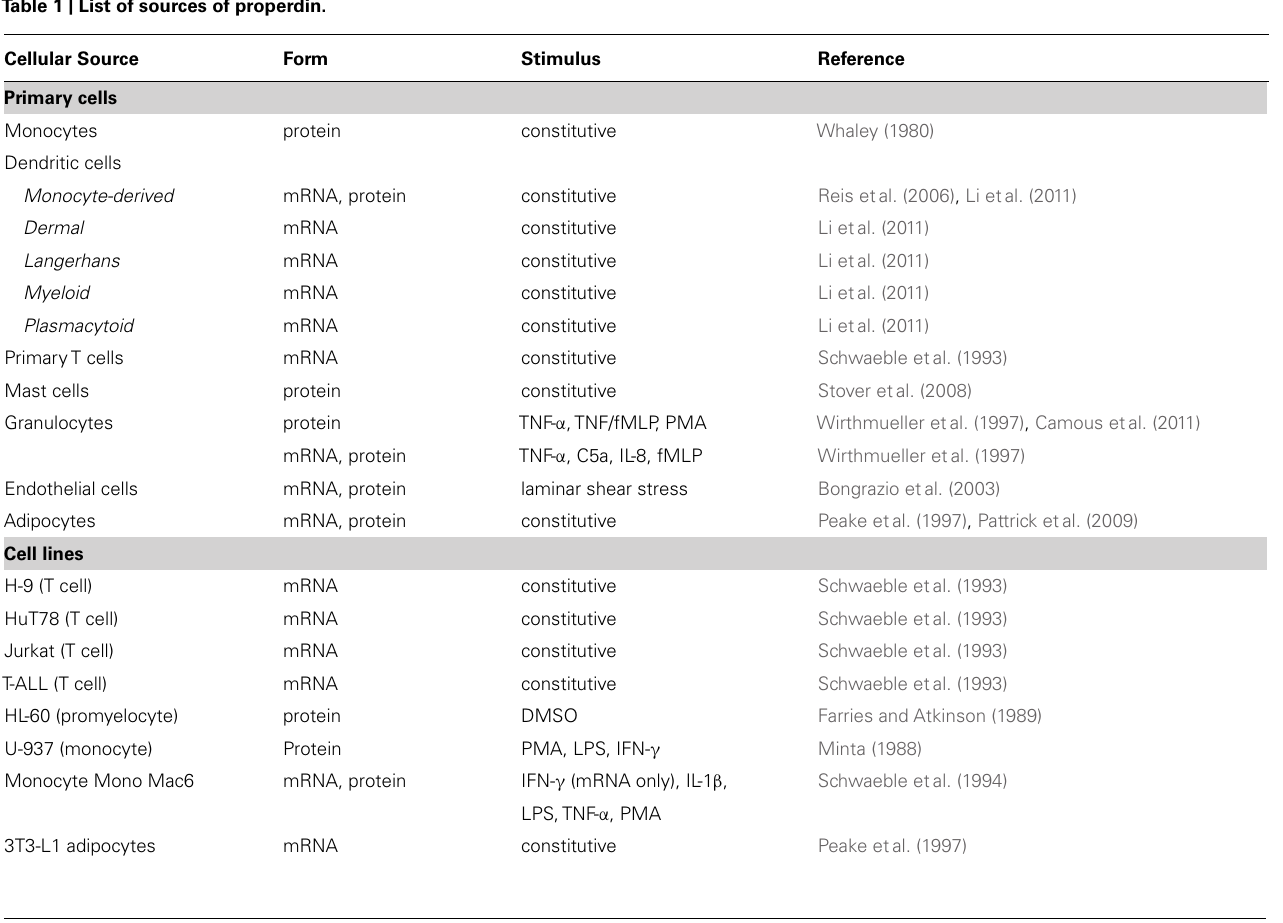
Table 1 | List of sources of